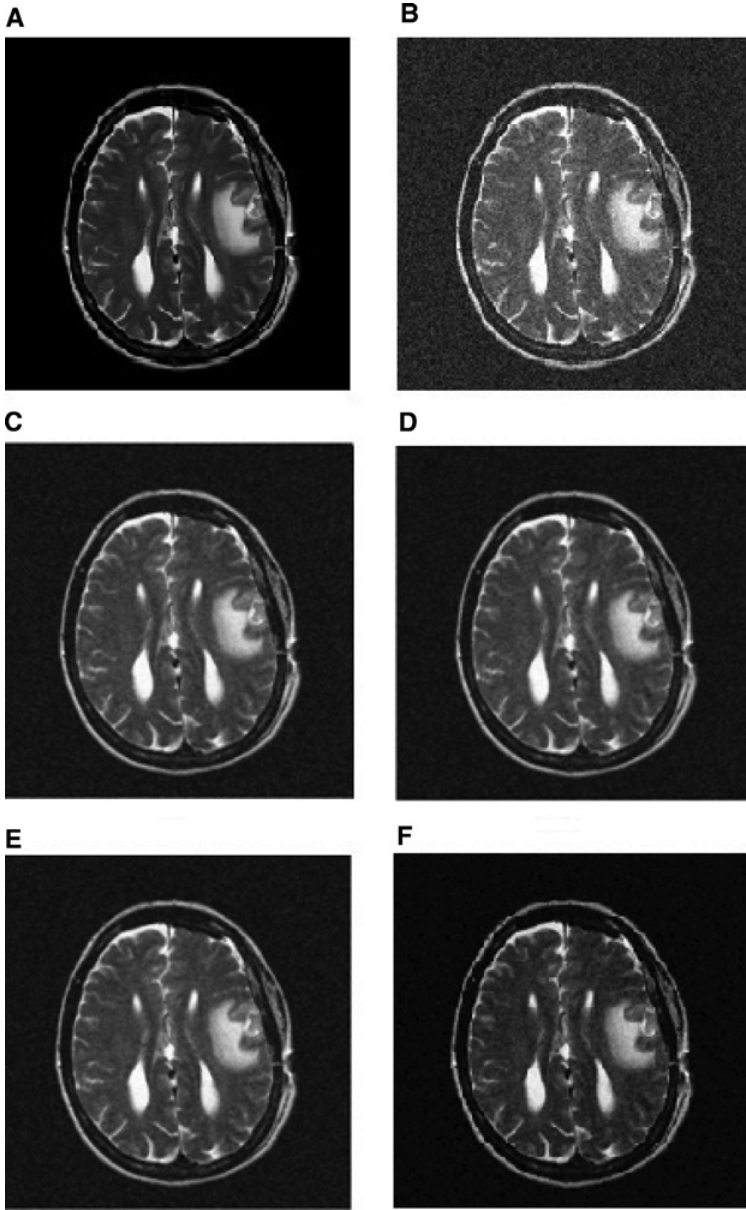
= 0.3. (C) Image de-noising using Donoho’s η